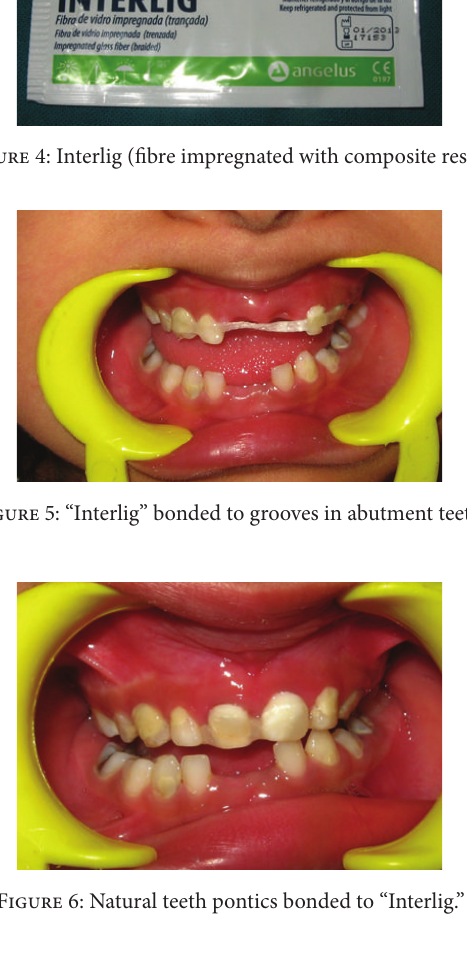
Figure 3: Natural teeth restored with composite to be used as pontics.